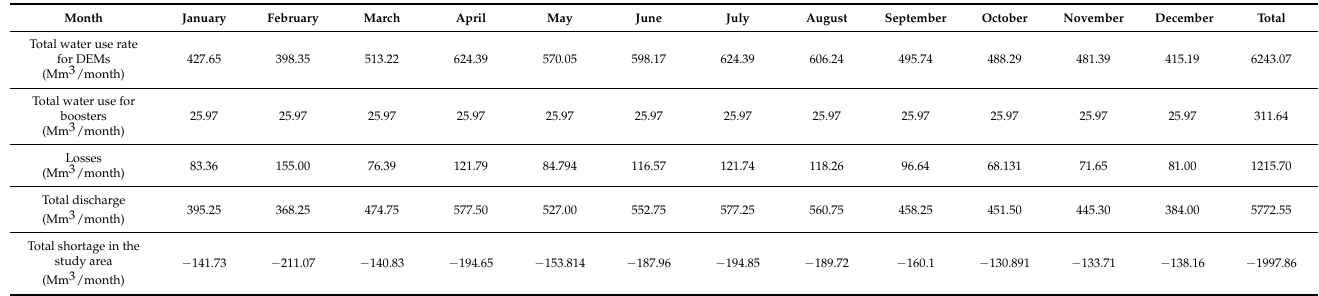
Table 6. Theoretical total water shortage in the study area (MCM).